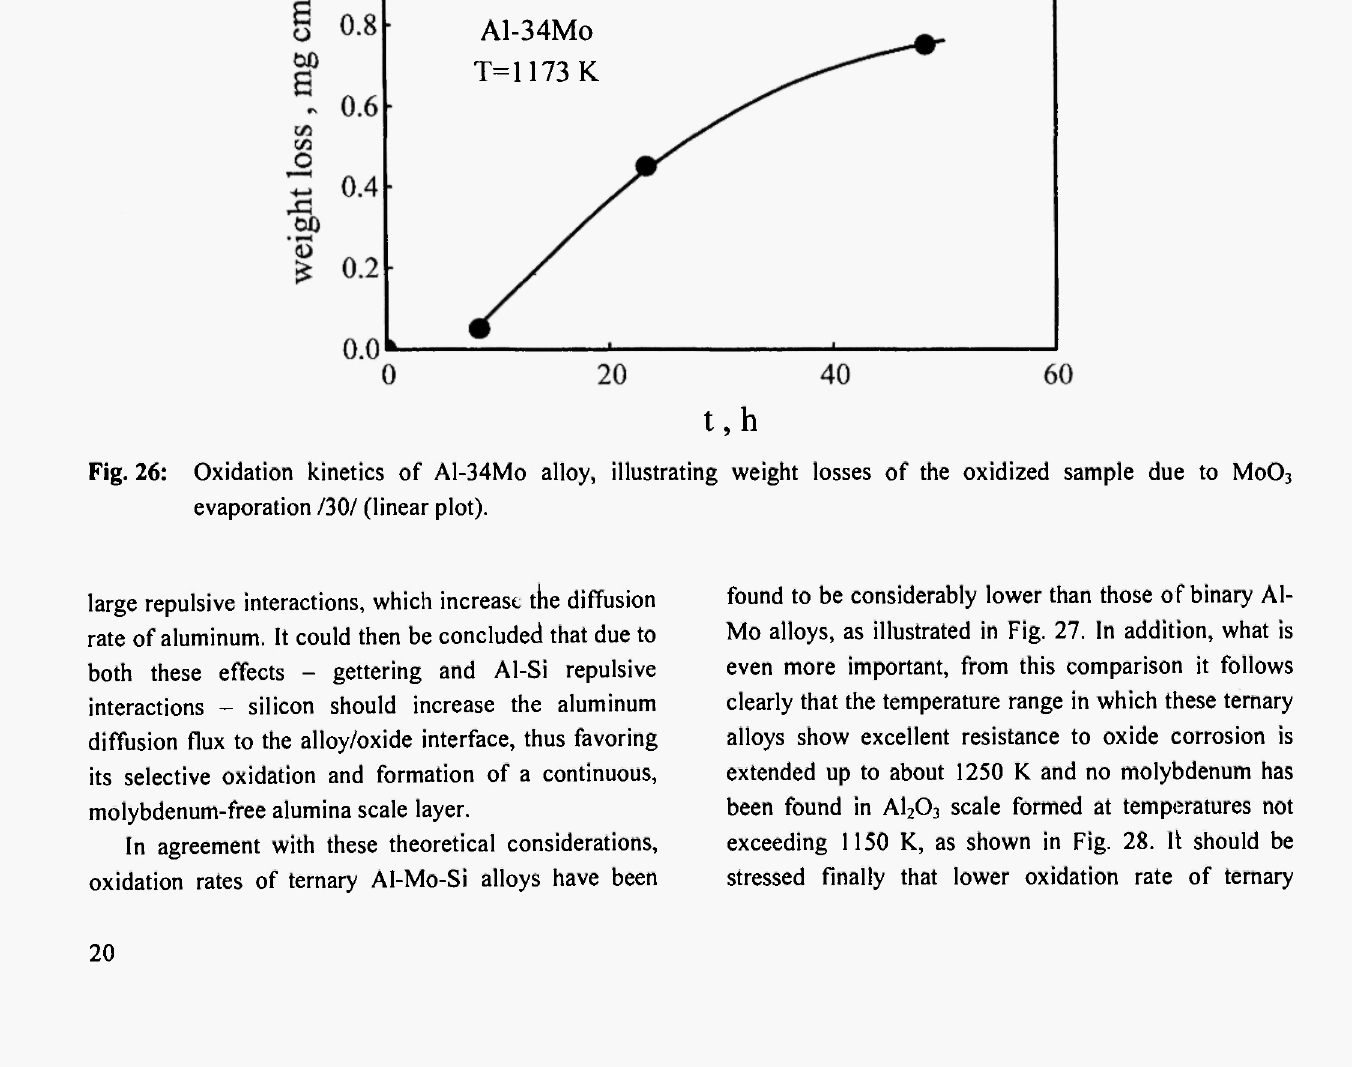
Fig. 25: Molybdenum concentration on the surface of the oxide scale formed on Al-34Mo alloy as a function of oxidation temperature /30/.